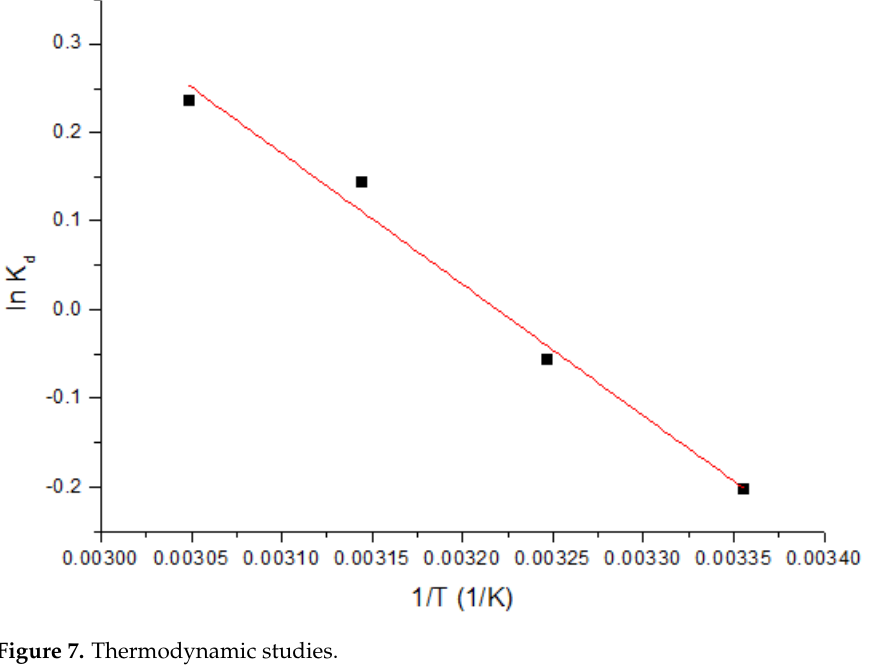
Figure 7. Thermodynamic studies.